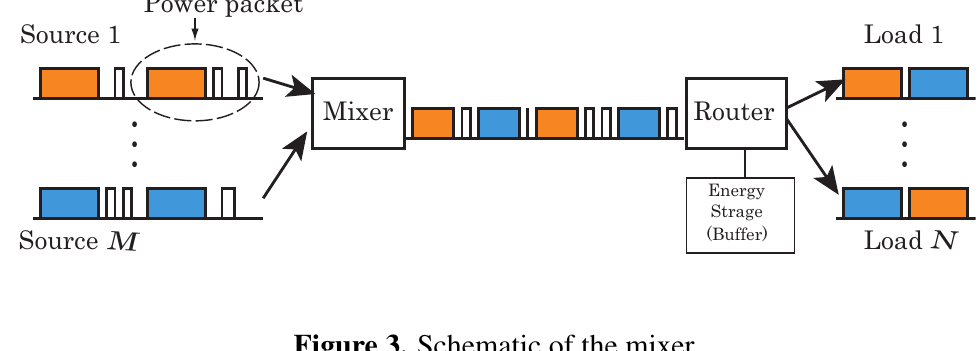
Figure 3. Schematic of the